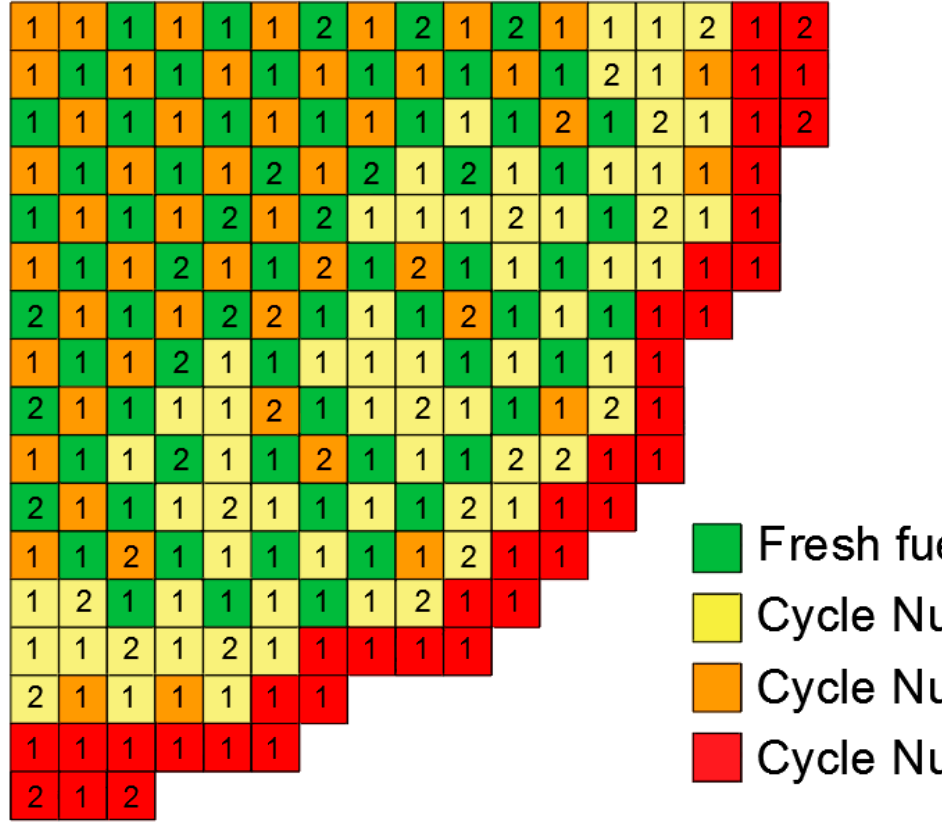
Figure 3. Full core equilibrium layout, with assembly numbers 1 or 2 and their burnup cycle inferred by the colour.